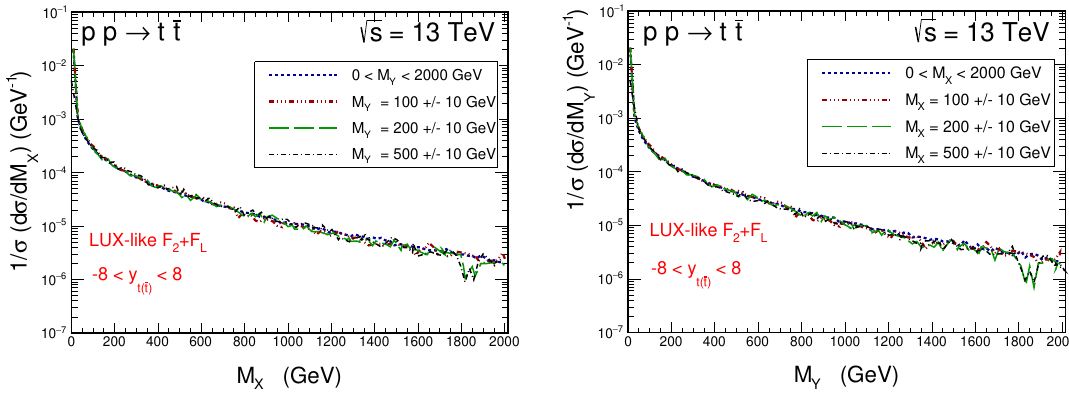
Figure 9 . Distribution in M X for di(cid:11)erent widnows of M Y (left) and as a function of M Y for di(cid:11)erent windows of M X